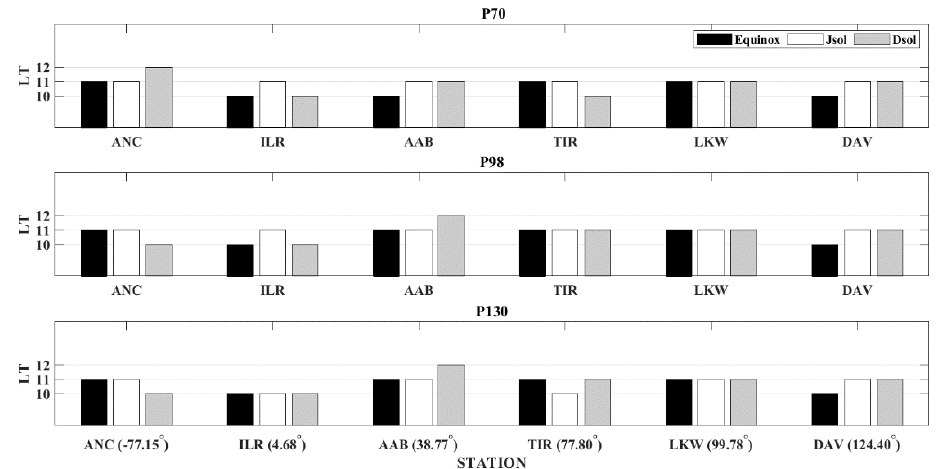
Figure 7. Bar plots for local time vs. longitude for ground measurements during low ( P = 70), moderate ( P = 98), and high ( P = 130) solar activity levels. The black, white, and grey plots represent the equinox, June solstice and December solstice, respectively.